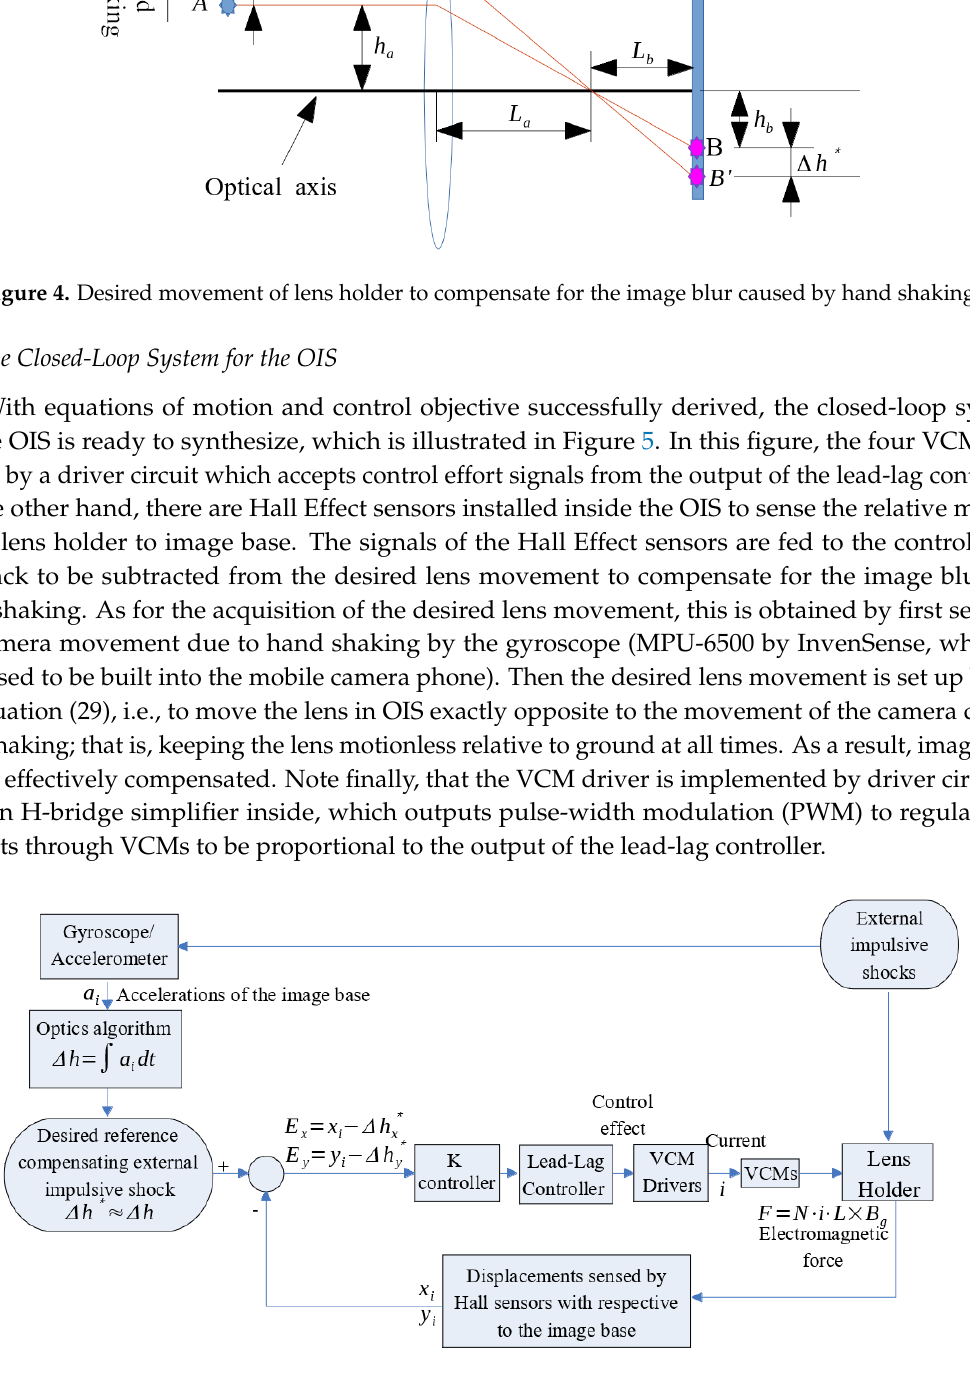
Figure 3. The optical working principles of OIS ( a ) under translational disturbance from hand shaking; ( b ) under rotational disturbance.